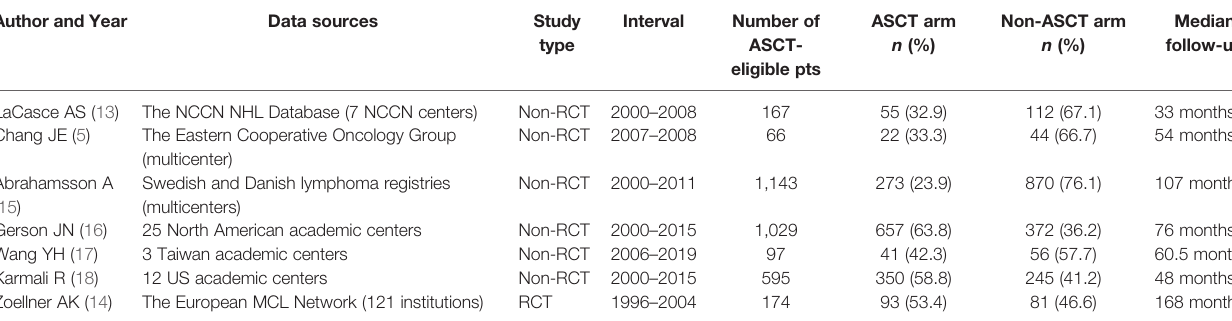
TABLE 2 | Characteristics of included